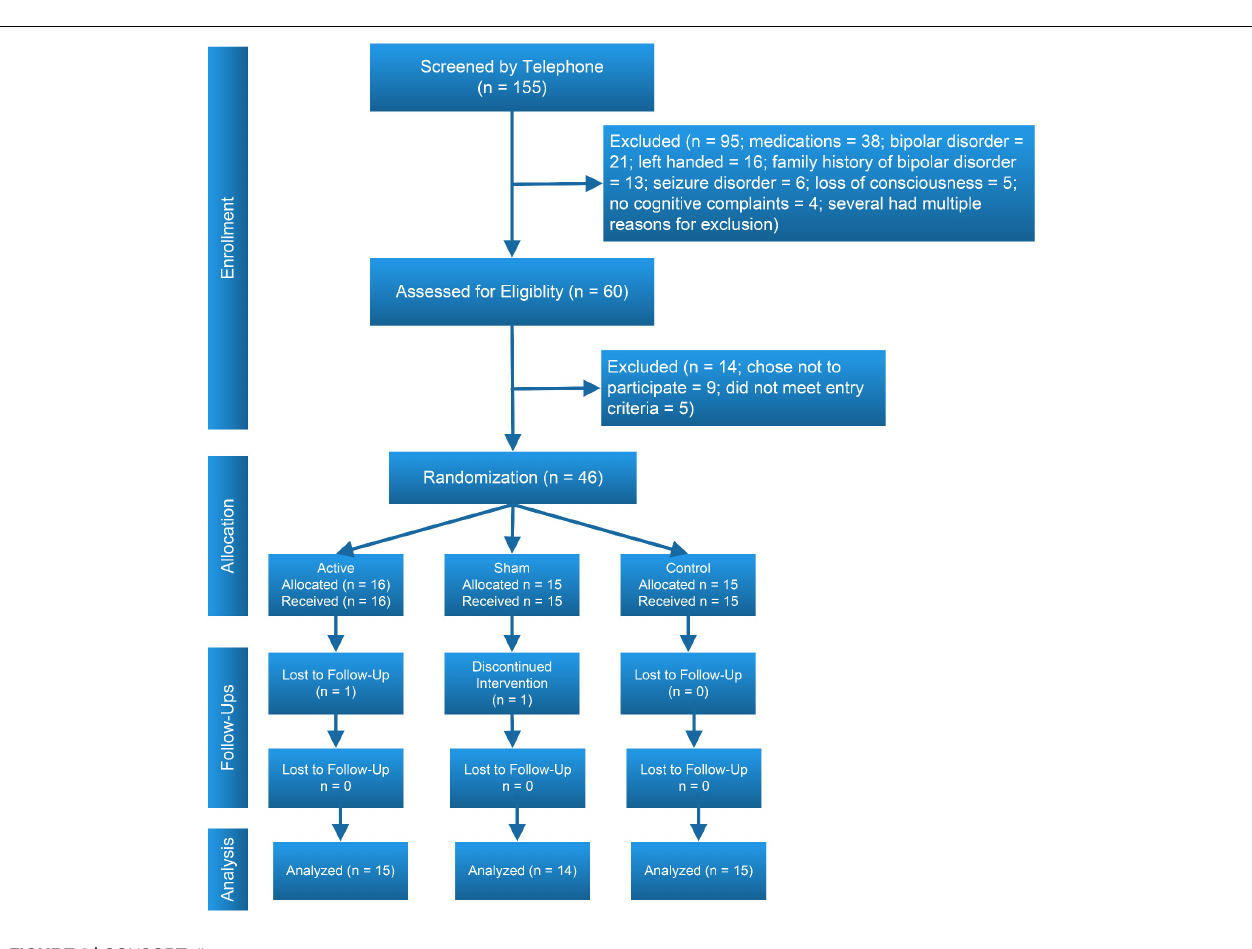
FIGURE 2 | CONSORT